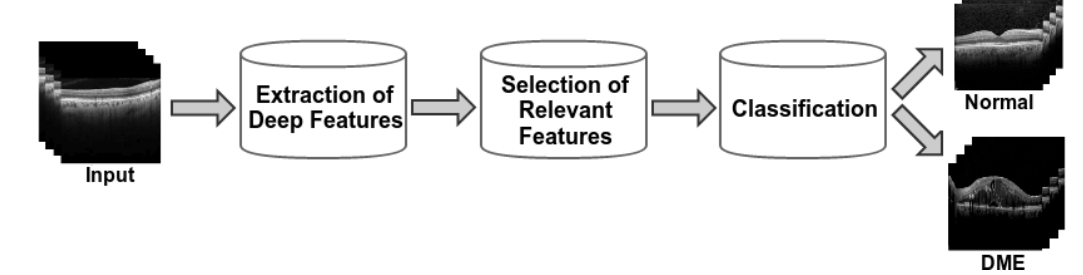
Figure 2. Main structure of the proposed